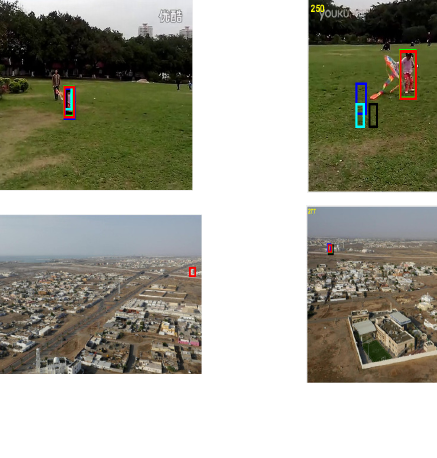
Figure 4. Center location error (in pixels) comparison on TC-128, OTB2013, OTB2015 and UAV123 datasets.